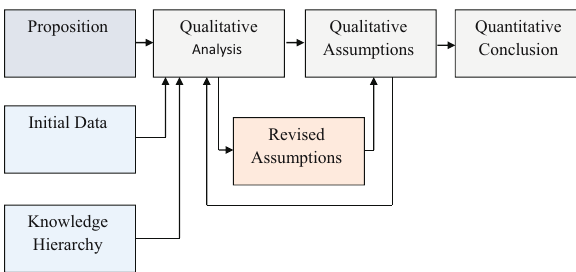
Figure 6: Controllable process of explicit